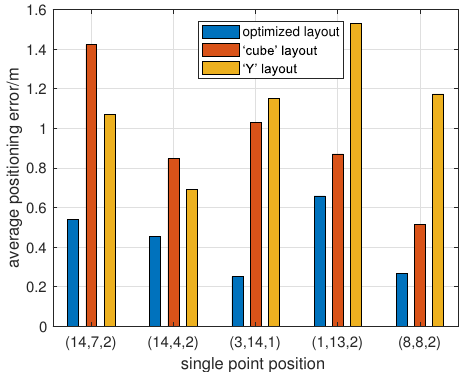
Figure 11. Average position error CDF